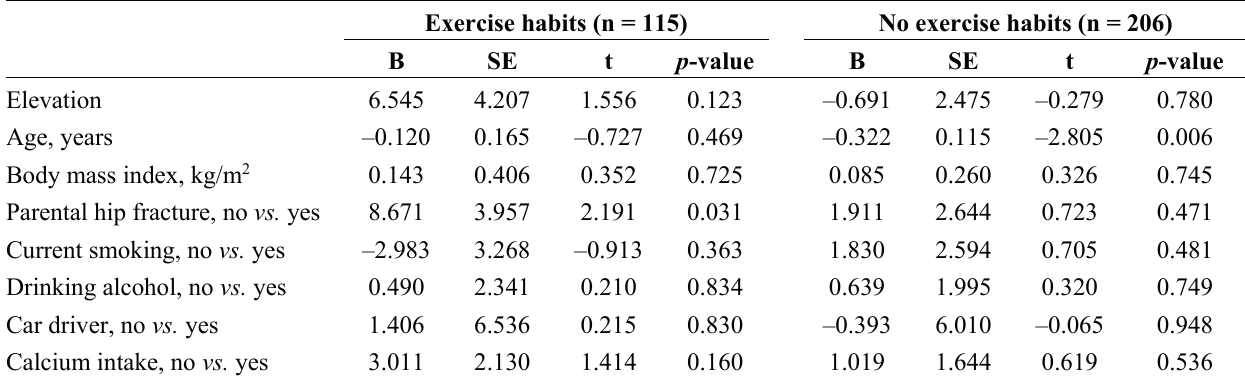
Table 2. Multivariable linear regression analysis among men. Exercise habits (n = 115)